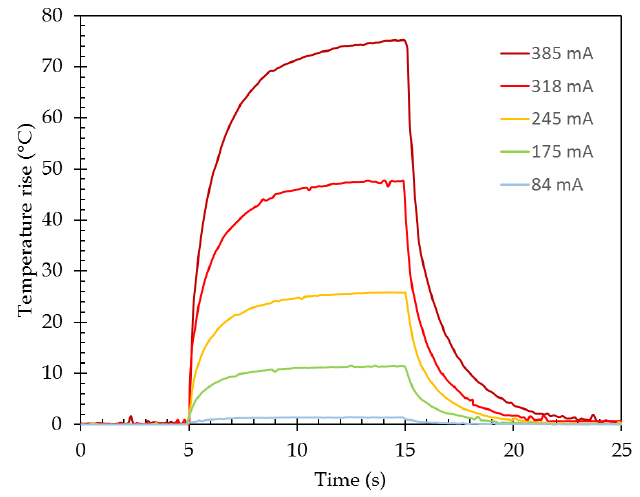
Figure 17. Experimental time response. The current pulse is applied between 5 and 15 s.